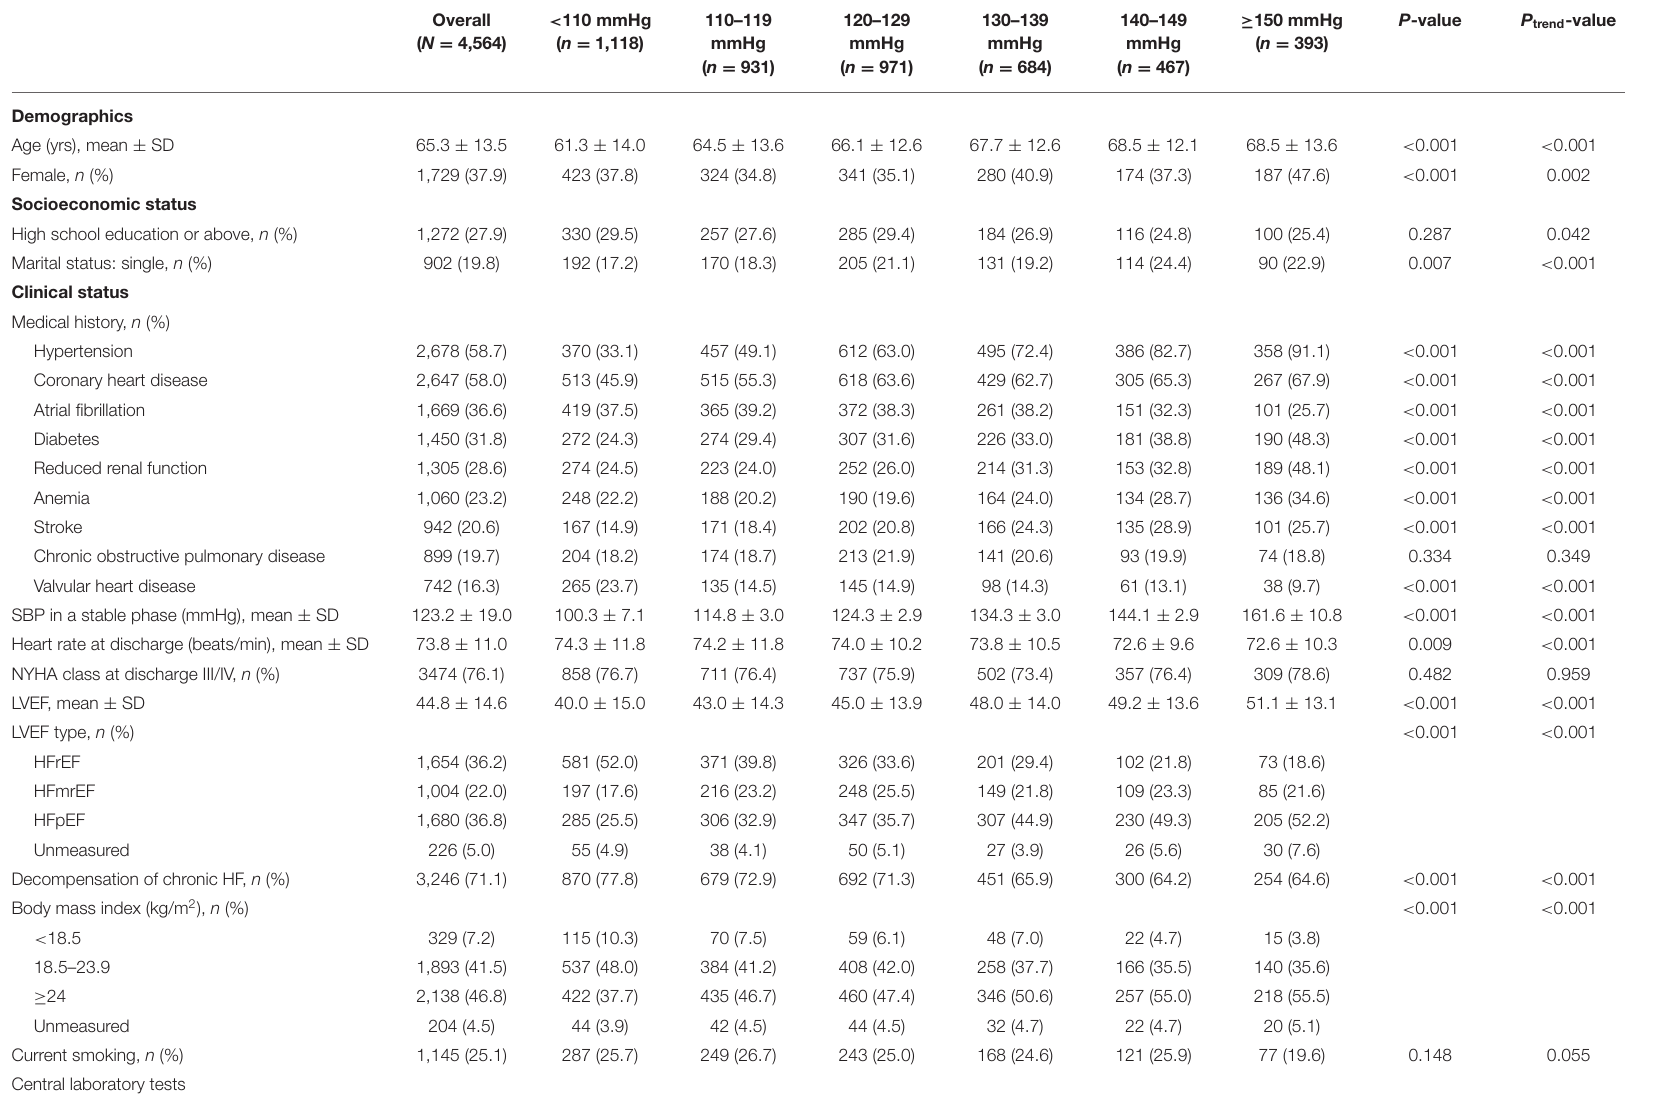
TABLE 1 | Baseline characteristics of patients by SBP